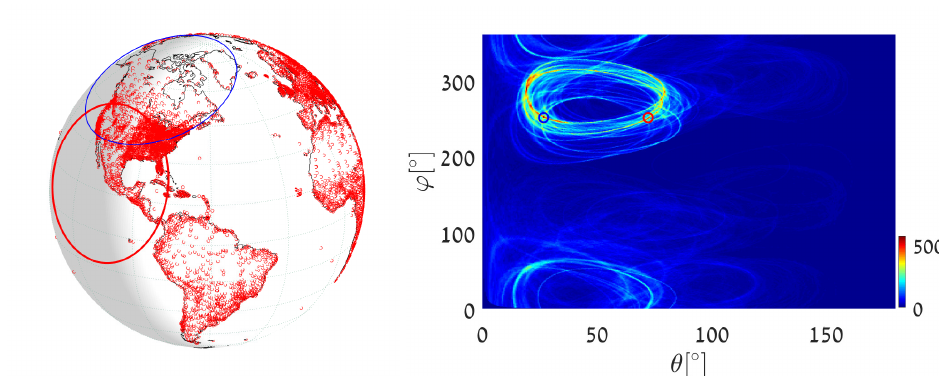
Figure 27. Executing Algorithm 3 with r = 0.5 on the city database. ( Left ) The blue circle passes through the maximum number (568) of cities (red dots). The red circle, passing through 523 cities, corresponds to the second maximum, following the unvoting process. ( Right ) Heat plot of the accumulator array M , showing the parameters of the two circles.